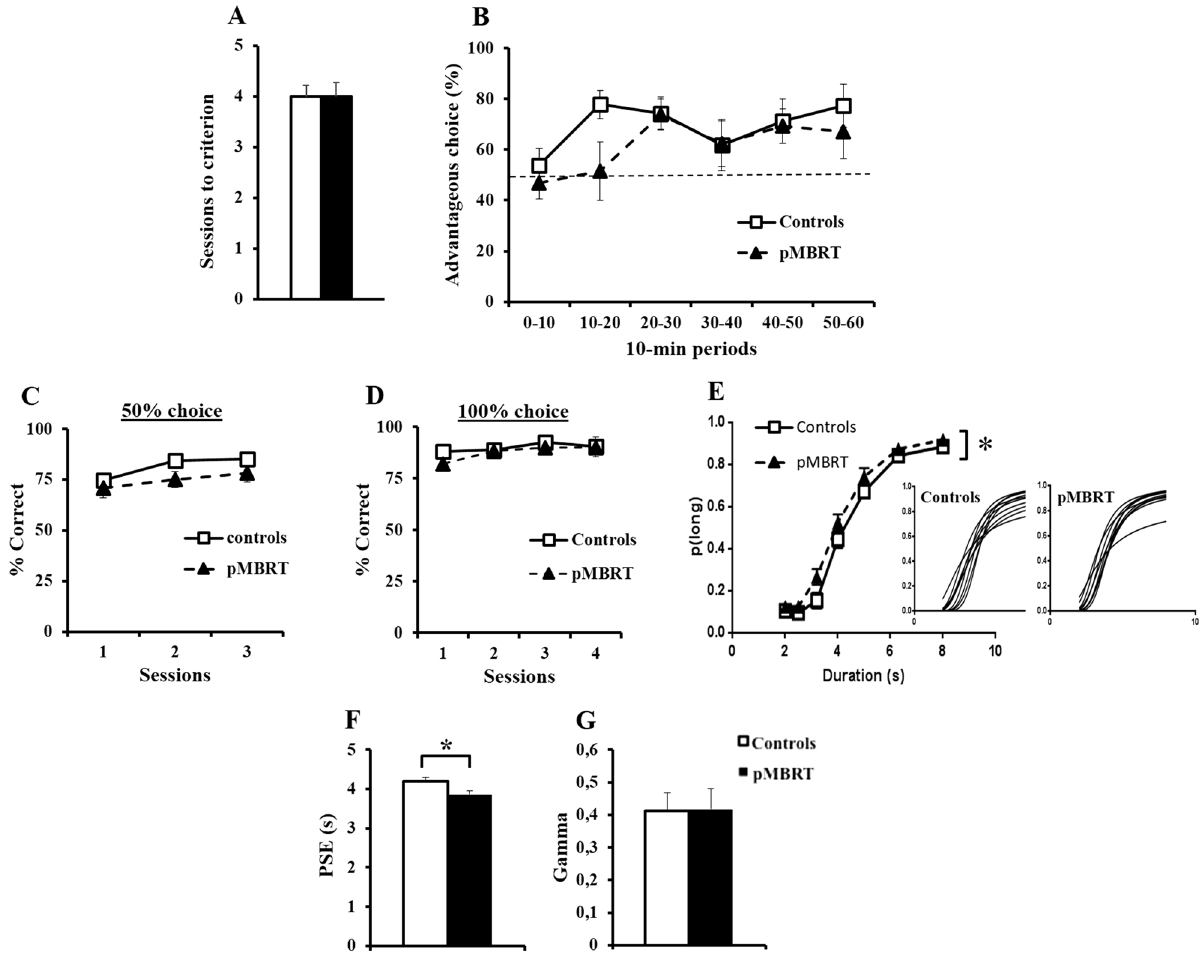
Figure 5. Executive functions assessment. Similar mean number of sessions needed to reach the criterion during RGT training for both groups ( A ). The mean percentage of advantageous choices in 10-min periods during the RGT session (dotted line: random choice) was not significantly different between the groups ( B ). Similar mean percentage of correct responses for both groups during the training sessions of the temporal discrimination task with 50% ( C ) and 100% ( D ) free choice. Compared to control animals, pMBRT animals showed a higher mean proportion of long responses (p(long)) as a function of stimulus duration during the bisection tests (insets: individual curves) ( E ). The point of subjective equality (PSE) was lower in pMBRT animals than in control animals ( F ), while the temporal precision (gamma) was not significantly different ( G ). The data are presented as the mean ±